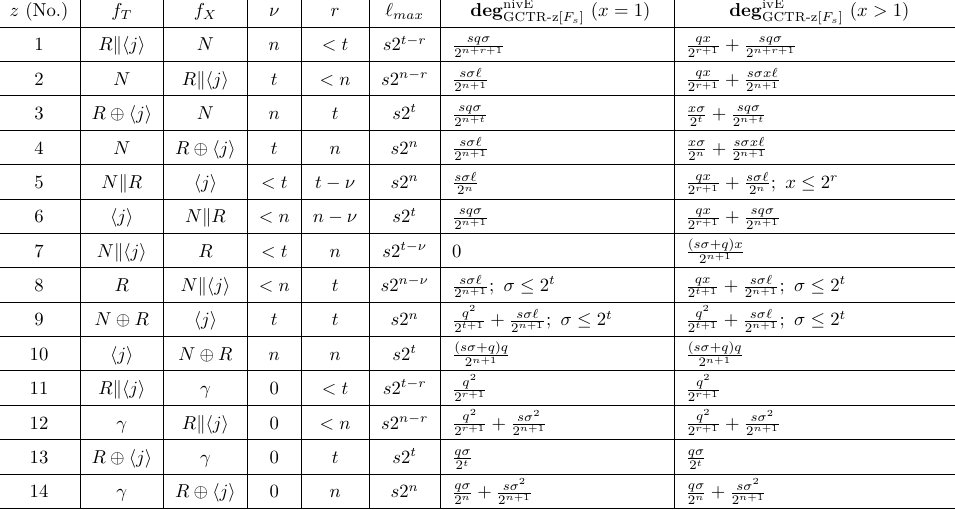
Table 2: GCTR[ F s ] variants for constructing a nivE scheme using a multiforkcipher. The columns “ f T ” and “ f X ” respectively show computation of the j th t -bit tweak and n -bit plaintext to the MFC F s . Here, q and σ are the total number of plaintext queries and MFC calls, respectively, R is an r -bit random value, N is a ν -bit nonce, j is a counter, γ is a constant, h j i is a constant-size encoding of an integer j , ‘ is the maximum of query lengths ‘ i s with 1 ≤ i ≤ q , and 1 ≤ x ≤ q is the upper bound on number of reuses (repetitions) for any nonce N i ( x = 1 means no nonce repeats). The column “ ‘ max ” contains the maximum number of possible n -bit blocks in a